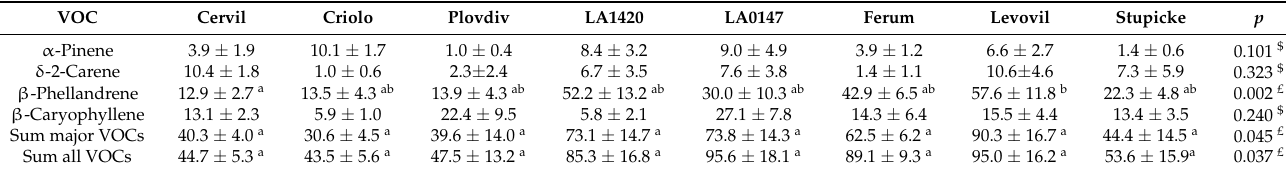
Table 1. VOC contents in leaf extracts ( µ g g − 1 leaf fresh weight) of the eight tomato genotypes. Data are means of 4–6 plant replicates ± SE. The sum of the four major compounds represent 70% to 95% of the sum of all stored VOCs. Other VOCs include myrcene, γ -terpinene, δ -elemene, methyl-salycilate, and eugenol. ANOVA and Kruskal Wallis statistics were used to test whether means are different among genotypes. p -values indicate the overall probability of the test results (significant if p < 0.05). Superscript letters indicate which of the genotypes differs at α < 0.05. VOC Cervil Criolo Plovdiv LA1420 LA0147 Ferum Levovil Stupicke